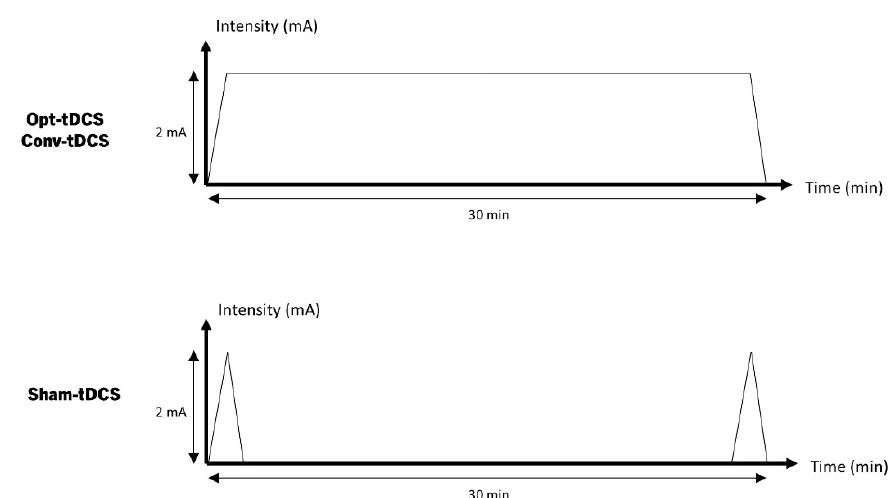
Figure 2. tDCS and sham tDCS protocol.